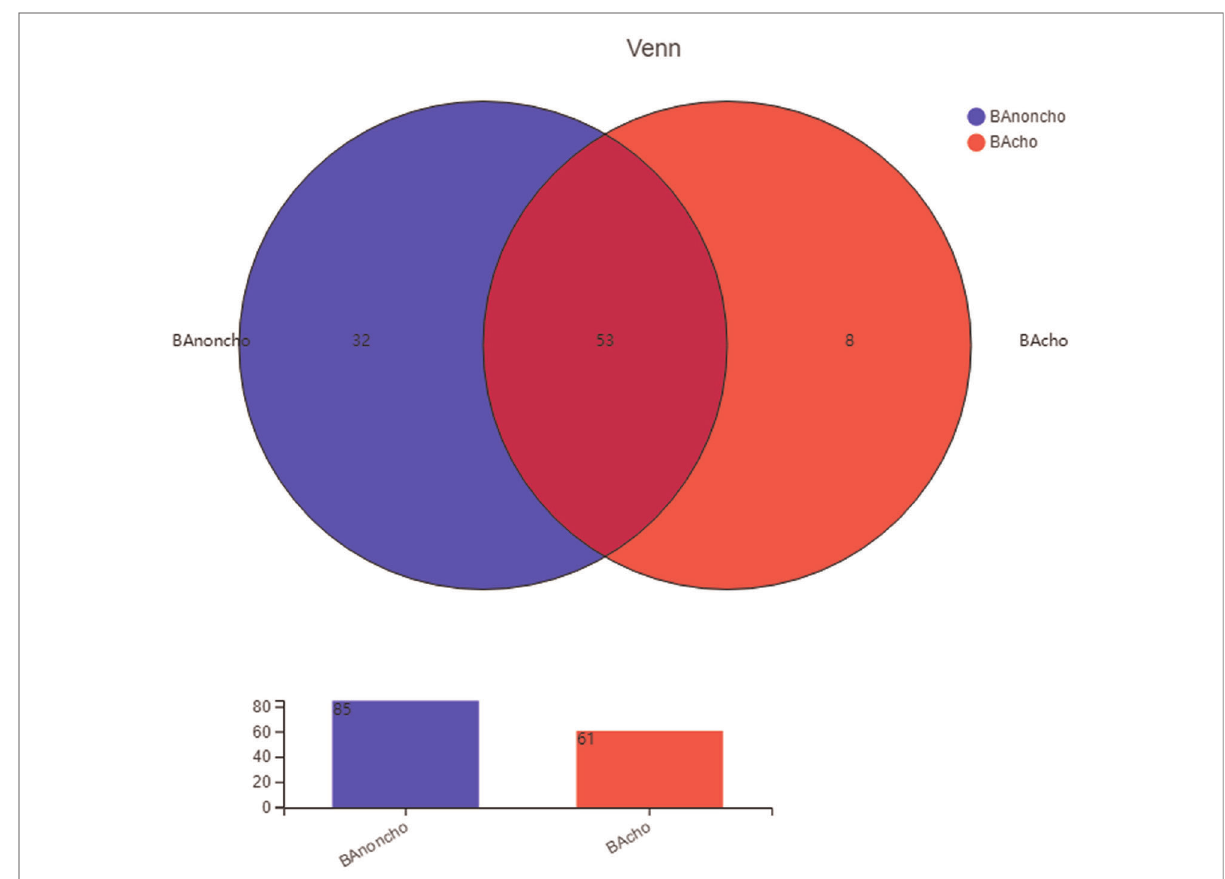
FIGURE 2 The kinds of gut microbiota in BAnoncho and BAcho group on genus level. There were 85 kinds of gut microbita in BAnoncho and 61 kinds in BAcho. There were 8 kinds of microbita on genus level only detected in BAcho group.